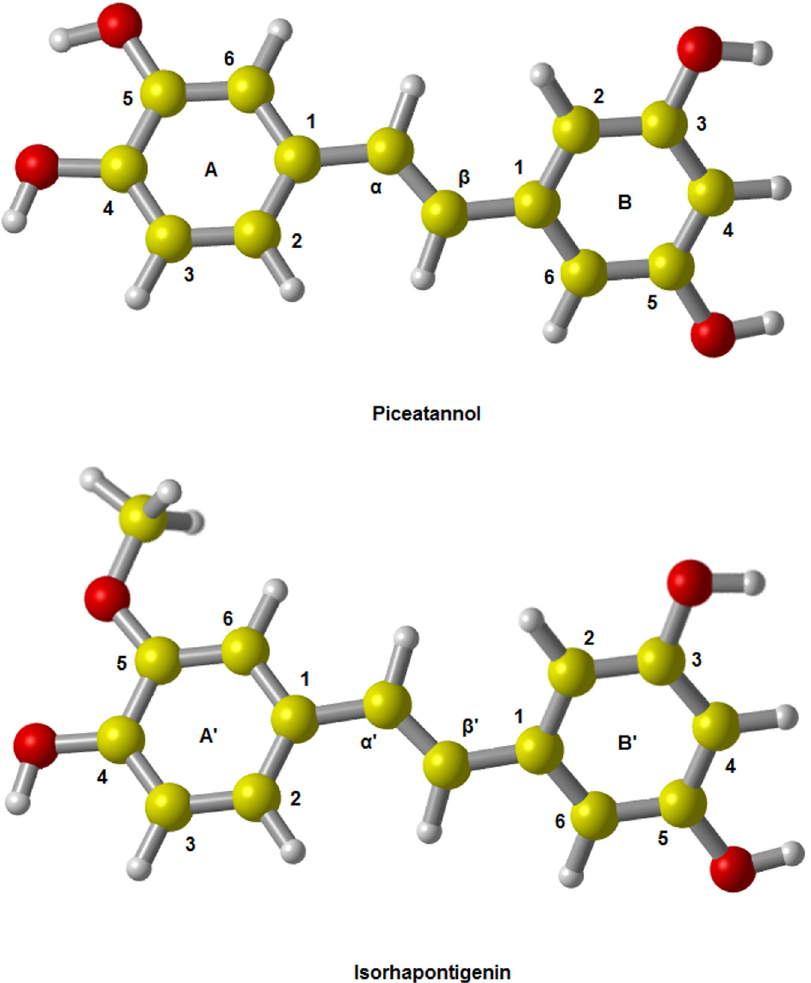
Fig 1. The optimized geometries of PIC and ISO in the gas phase. The results show that both of PIC and ISO have an approximately planar structure. The dihedral angle between two benzene rings of PIC is about 179.95°, which is very consistent with the experimental result of 179.23°; the corresponding dihedral angel of ISO is